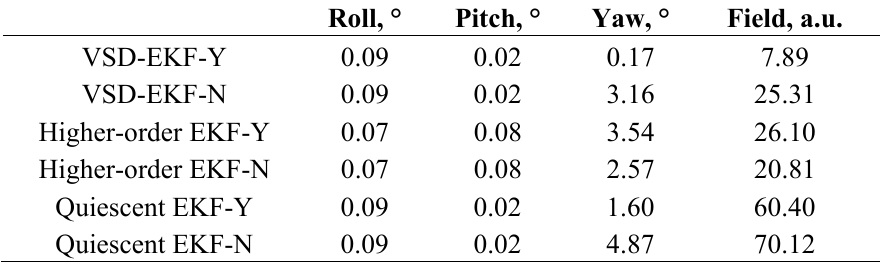
Table 3. Euler angles and magnetic distortion RMSE (static test).